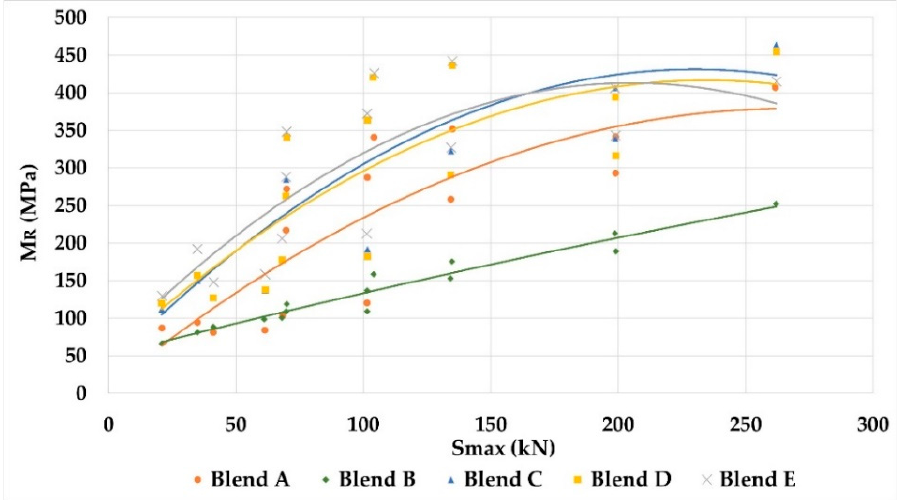
Figure 6. M R values regarding the maximum applied axial stress S max.